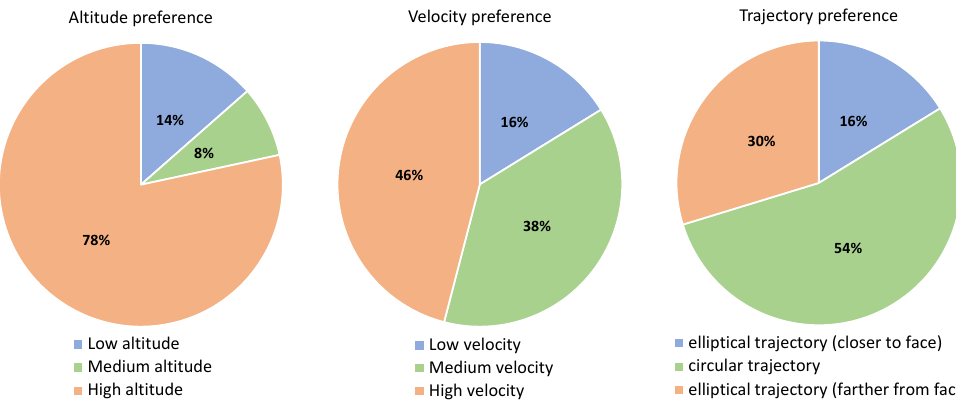
A.SAF1A.SAF2A.SAF3A.SUP1A.SUP2A.SUP3A.DIS1A.DIS2A.DIS3V.SAF1V.SAF2V.SAF3V.SUP1V.SUP2V.SUP3V.DIS1V.DIS2V.DIS3V.ADE1V.ADE2V.ADE3T.SAF1T.SAF2T.SAF3T.SUP1T.SUP2 Figure 11. Distribution of responses for each question for older adults. Figure 12. User preference for each of the variables measured for older